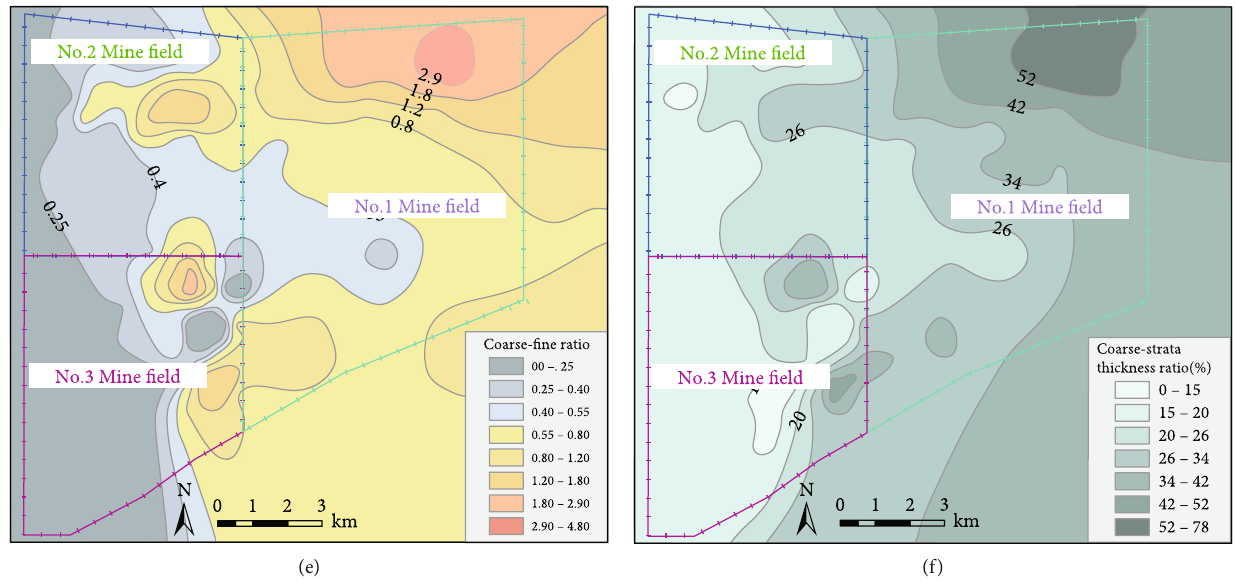
Figure 3: Contour maps of lithofacies paleogeographic factors of the middle member of Xishanyao Formation of the western Dananhu coal fi eld: (a) total stratum thickness; (b) conglomerate thickness; (c) thickness of coarse sediment; (d) coal thickness; (e) coarse- fi ne ratio; (f) coarse sediment